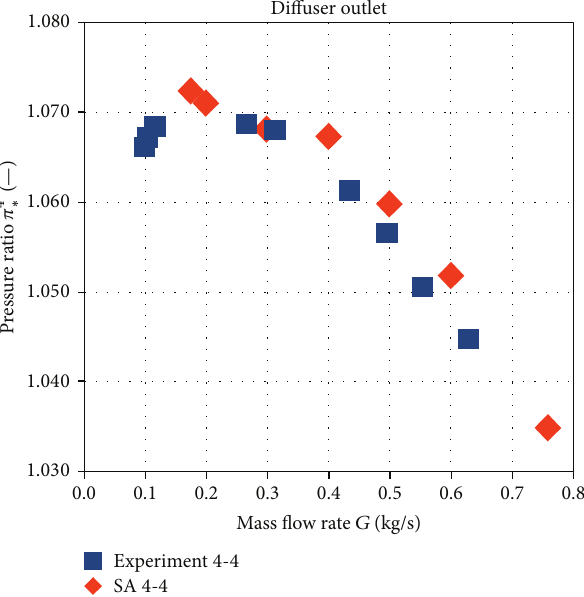
Figure 8: Pressure characteristic at the diffuser outlet for the Spalart-Allmaras turbulence model using second-order central dis- cretization.